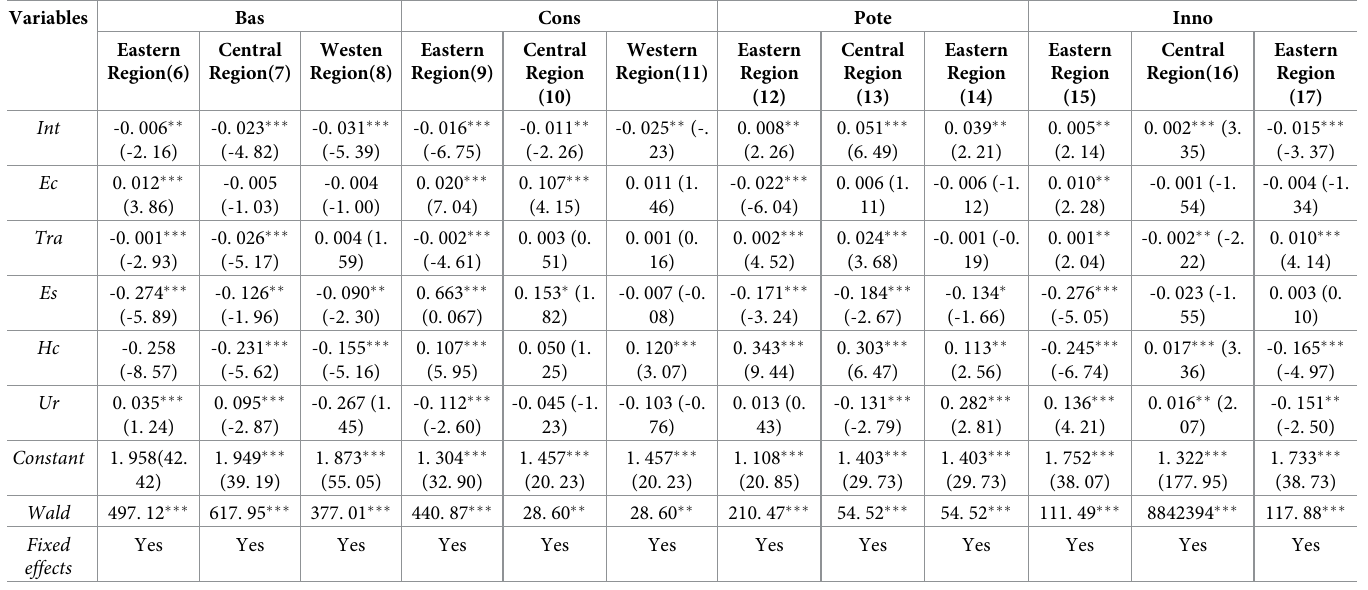
Table 7. The influence of the intelligentization of sub-region and sub-dimension on industrial competitiveness.